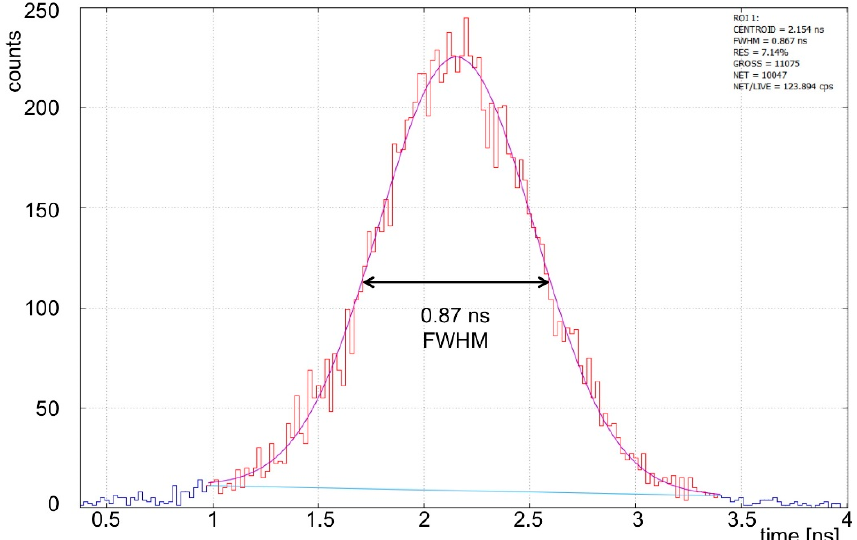
Figure 28. Coincidence time spectrum between two LaBr scintillators hit by back-to-back 511 keV gamma rays emitted by a 22 Na source. The FWHM resolution is well below 1ns.